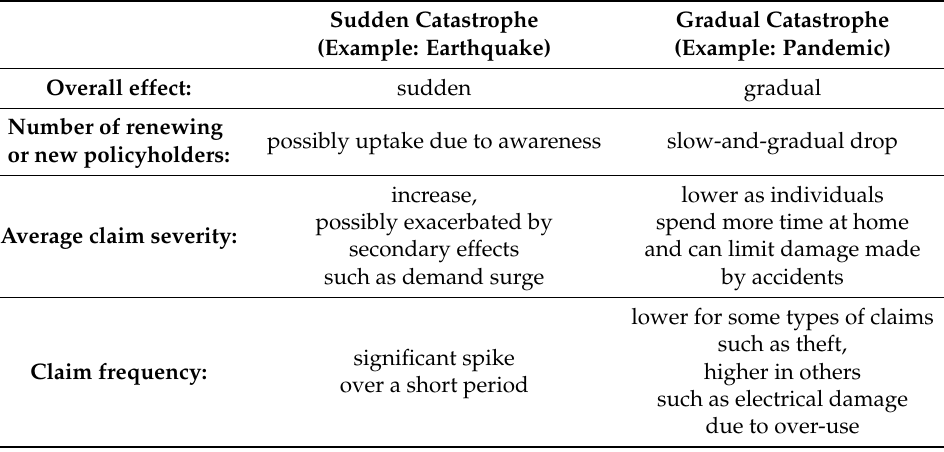
Table 3. Summary of effects of catastrophe risks on household